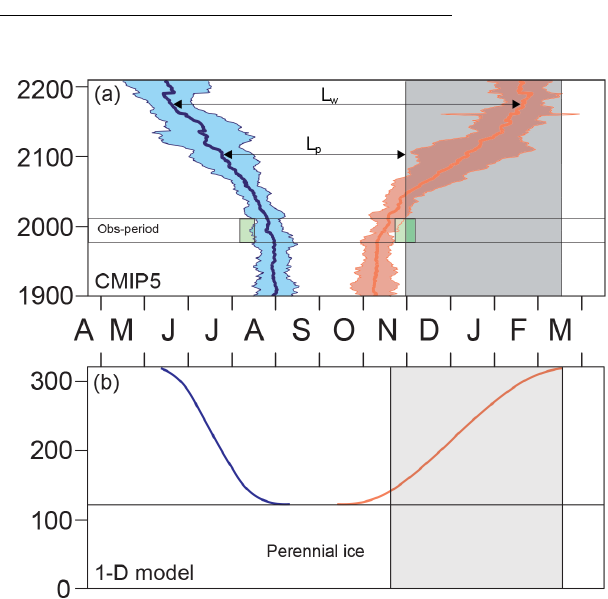
Figure 1. Evolution of the ice seasonality diagnostics (ice retreat date, blue; ice advance date, orange): (a) CMIP5 median and in- terquartile range, with corresponding range of satellite-derived val- ues (green rectangles 1980–2015) over the 70–80 ◦ N latitude band; (b) one-dimensional ice–ocean model results. The ice-free period ( L w ) , the photoperiod ( L p ) and the average polar night (grey rectan- gle) are also depicted. Note that the systematic difference between observations and CMIP5 models is reduced when accounting for the systematic bias due to the daily interpolation of monthly means in CMIP5 models (see Sect. 2 and Table